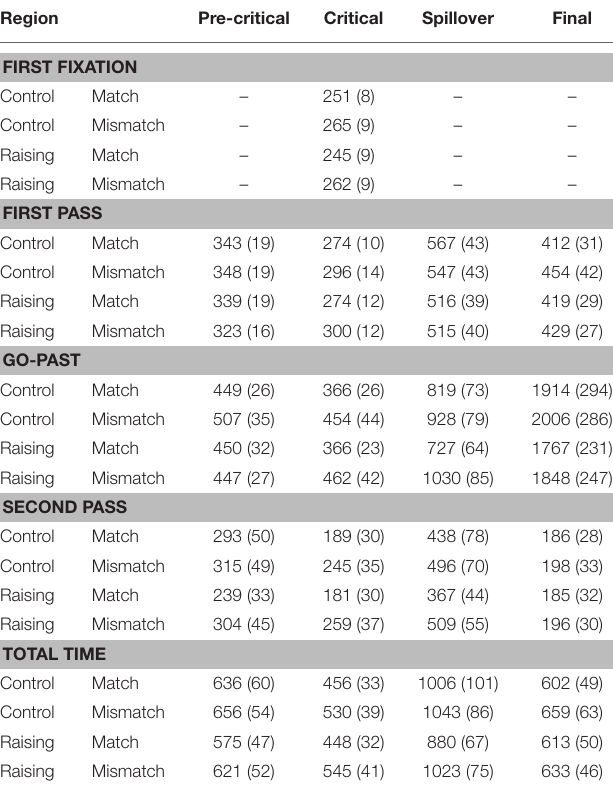
TABLE 3 | Means (and Standard Errors) for Experiment